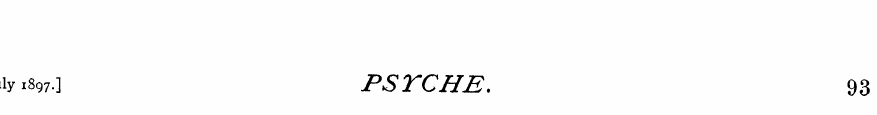
on apex or wholly so, with reddish-yellow on adjoining posterior part of thorax extend- ing extensively on sides. Abdomen soft black or brownish-black, first segment with a whitish spot in middle; second with an oblique white marking on sides widened posteriorly and reaching hind margin, and with a narrow white hind border on median portion. Third segment with a subsemicir- cular or triangular median white spot on hind margin, and an oblique lateral marking smaller than that of second segment. Fourth with a large median white triangle reaching front margin, and small lateral spots faint or subobsolete. Fifth with a small white median triangle, lateral spots faint or sub- obsolete. Sixth and seventh segments show the median and lateral white only when the insect is held on a level with the eye. Legs as in